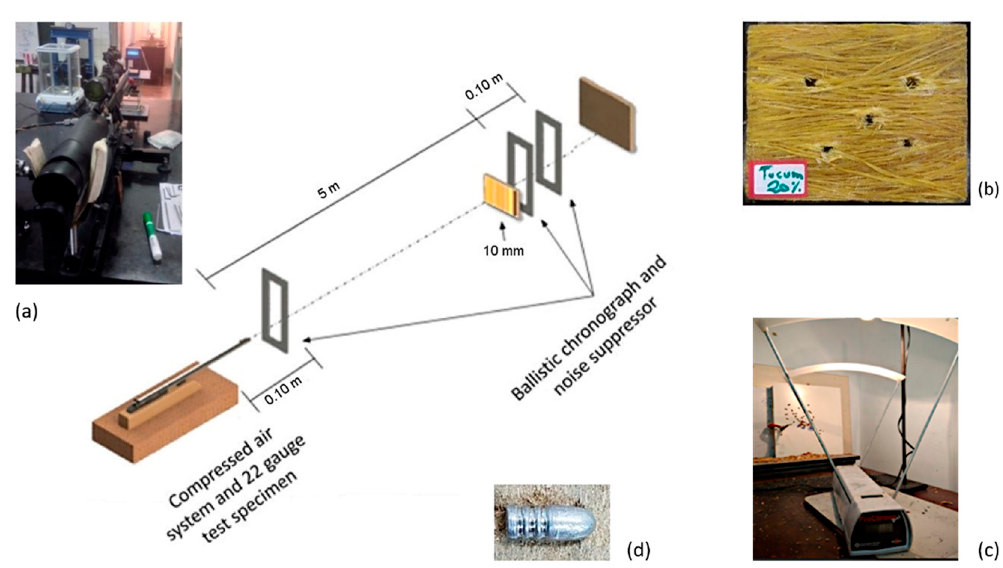
Figure 3. Schematic of apparatus used in the ballistic test: ( a ) compressed air gun; ( b ) perforated composite sample; ( c ) chronographs; and ( d ) .22 ammunition.